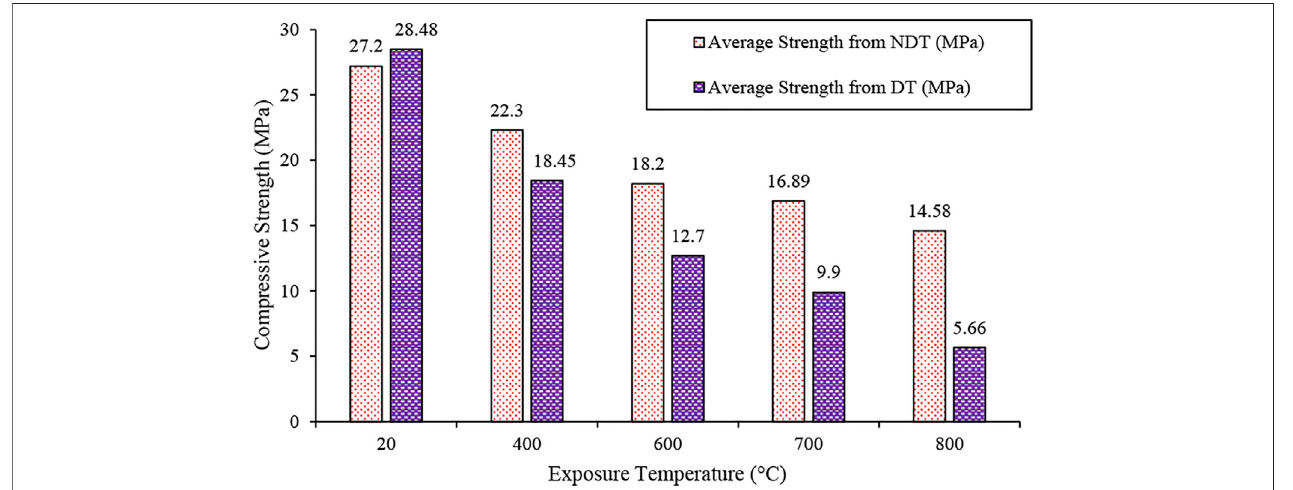
FIGURE 9 | Comparison between non-destructive and destructive testing for heated and unheated